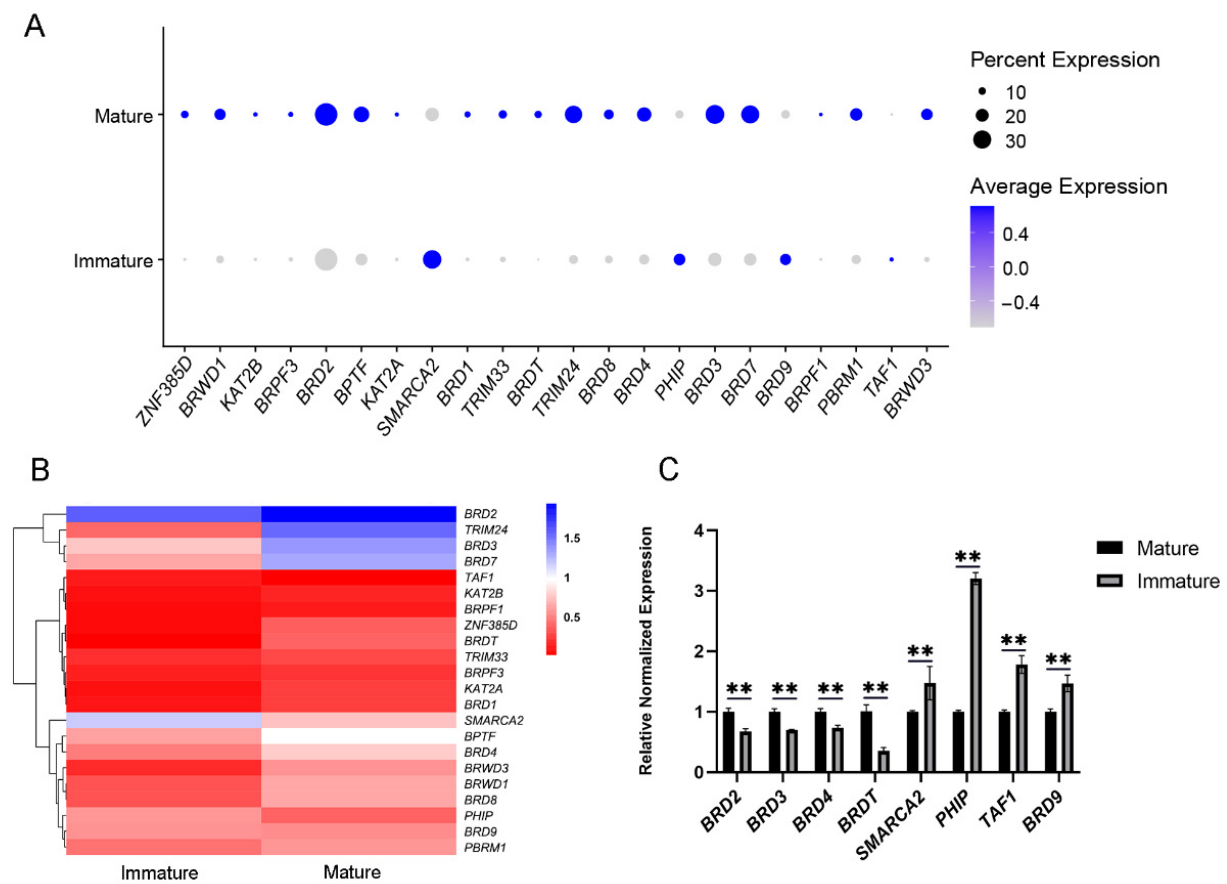
Figure 6. Dot plot ( A ) and heatmap ( B ) of BRD genes in immature and mature SCs, and verification of chosen buffalo BRD genes by qRT-PCR ( C ). The dot size represents the numbers of genes, and the color shade represents the expression level of genes in SCs. ** Significant difference.